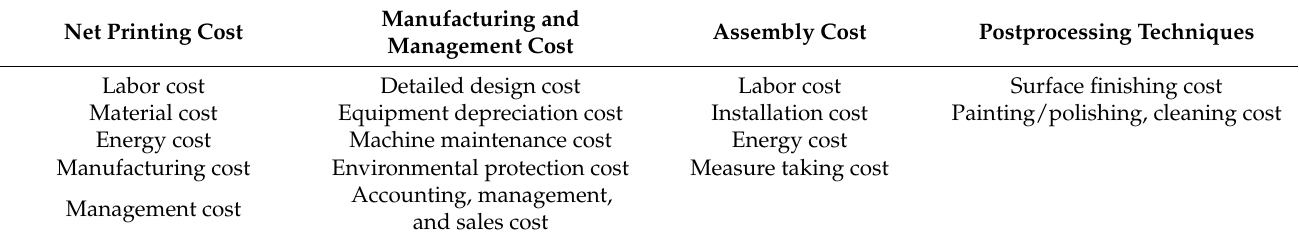
Table 7. Factory site 3D printing cost factors.